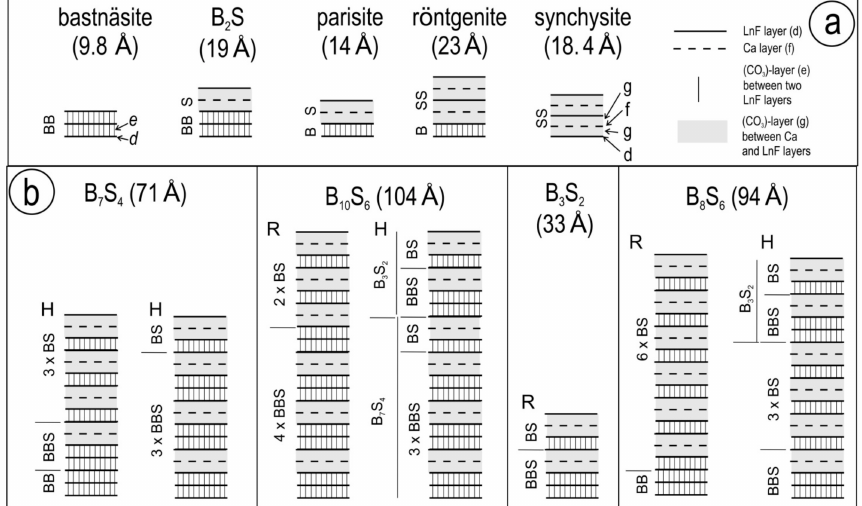
Figure 1. Schematic representation of mixed-layer compounds in the bastnäsite-synchysite group based on the structural model of Donnay and Donnay [15]. Numbers in brackets represents the width of the sequence shown as: one period of the layer sequence except for bastnäsite and synchysite, which are shown as 2 periods (corresponding to 2 × a” and 4 × a (cid:48)(cid:48)(cid:48) , respectively in ( a )); ( b ) shows polysomes and their polytypes in the range between B 2 S and parisite [16,18]. H—hexagonal;